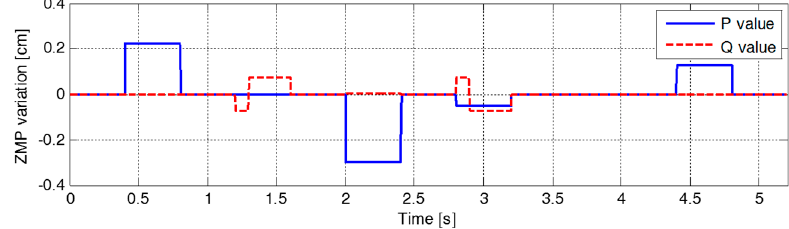
Figure 13. Variation in parameters for ZMP functions in the second simulation.